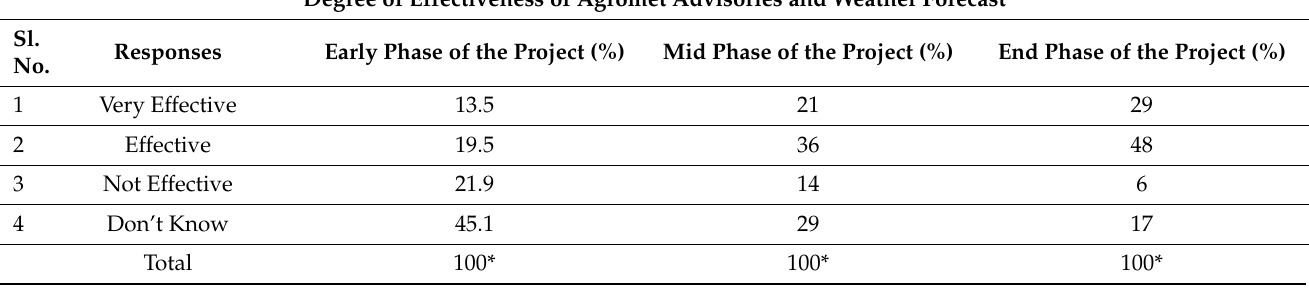
Table 4. Degree of effectiveness of agromet advisories and weather forecast.